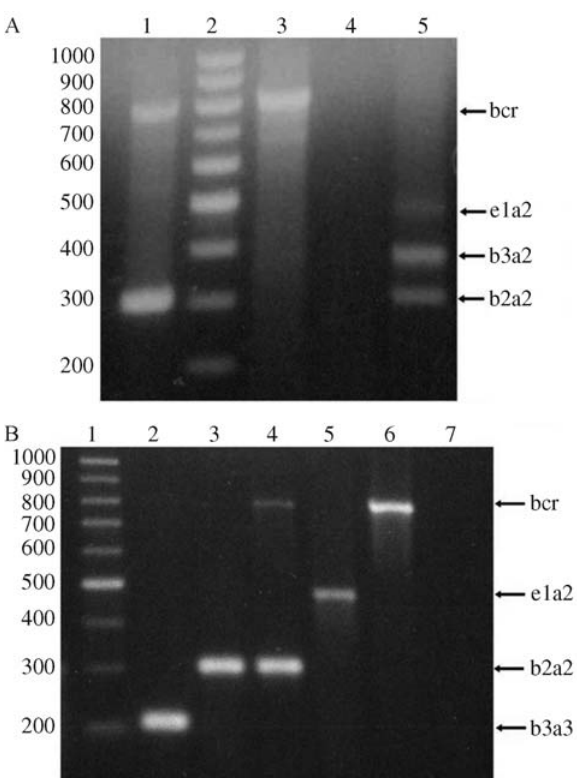
Figure 1 - A - Agarose gel electrophoresis of multiplex-PCR products in patient samples. Lane 1: b2a2 positive CML patient. Lane 2: molecular weight marker. Lane 3: BCR-ABL(-) ALL, the 808 bp product corre- sponds to the normal BCR gene. Lane 4: negative control. Lane 5: three bands observed in a CML patient, corresponding to e1a2 (481 bp), b2a2 (310bp)andb3a2(385bp),respectively.Thepresenceofthesetranscripts was confirmed by nested PCR. B - Detection of a variant rearrangement (b3a3) by multiplex-PCR. Lane 1: molecular weight marker. Lane 2: a 210 bp band corresponding to the b3a3 rearrangement in a CML patient. Lane 3: BCR-ABL(+) ALL, Lane 4: CML patient with b2a2 rearrange- ment. Lane 5: BCR-ABL(+) ALL with e1a2 rearrangement. Lane 6: BCR-ABL(-) ALL, the 808 bp band corresponds to the normal BCR gene. Lane 7: negative